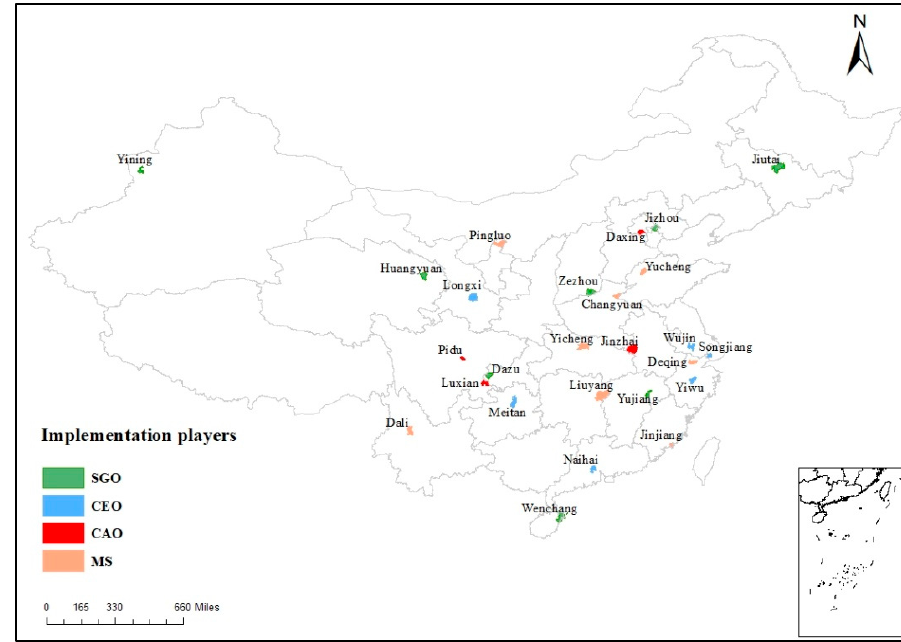
Figure 5. Type of implementation subjects for each pilot area.